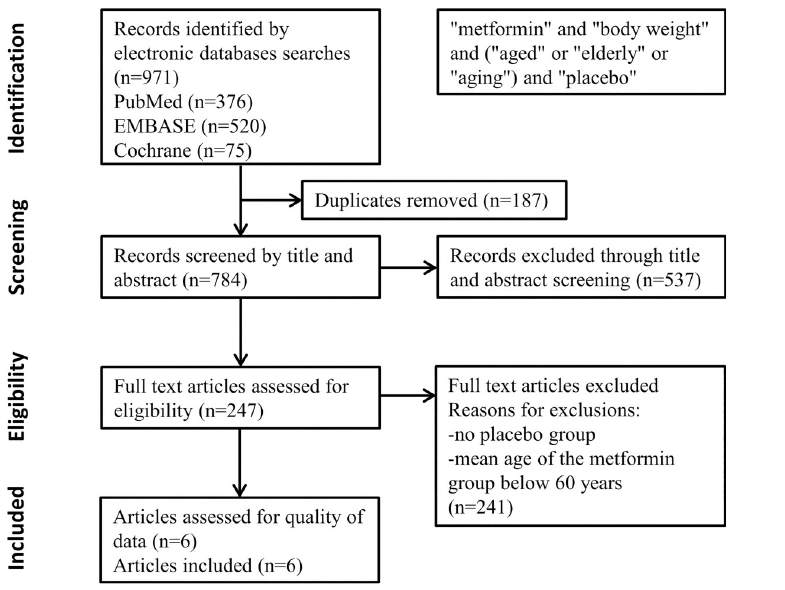
Fig 1. PRISMA flow diagram detailing process of study selection for the meta-analysis.